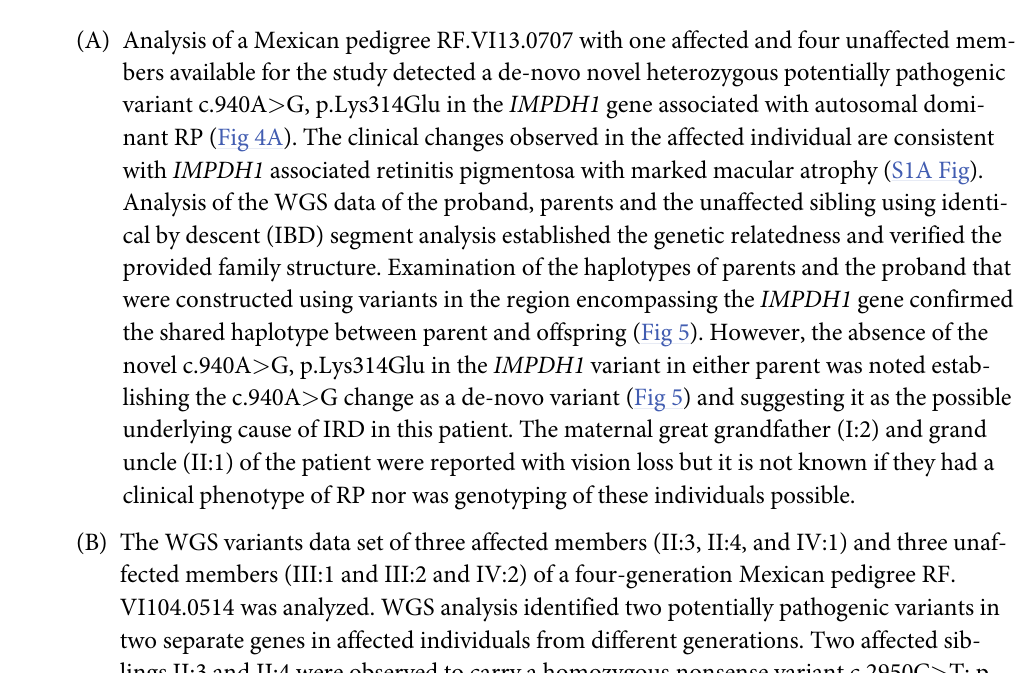
Fig 5. Haplotype of parents and the proband constructed with variants flanking the de-novo variant detected in the IMPDH1 gene in RF.VI13.0707 pedigree (Fig 4A).